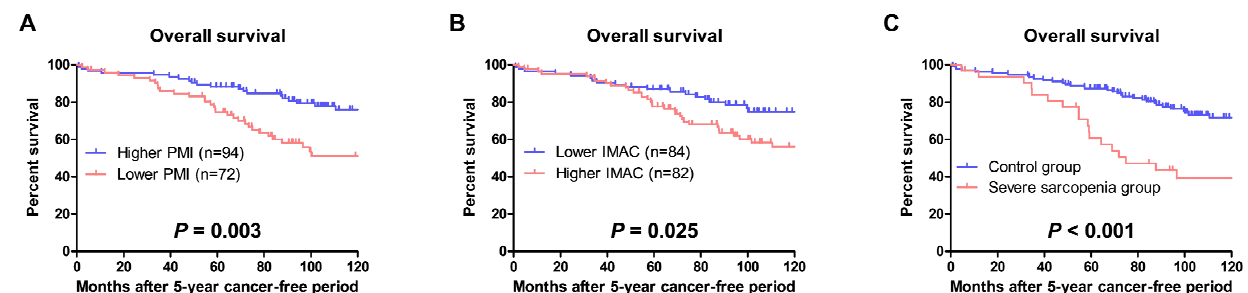
Figure 4. Overall survival. Overall survival after a 5-year cancer-free period was evaluated using the Kaplan–Meier method and compared using the log-rank test between patients with higher and lower psoas muscle index (PMI) values ( A ), lower and higher intramuscular adipose tissue content (IMAC) values ( B ), and patients in the control and severe sarcopenia groups ( C ). By the end of the follow-up period after the 5-year cancer-free period, 37 (28%) and 21 (66%) patients in the control and severe sarcopenia group died from non-cancer-spe- cific cause, respectively. The 5-year and 10-year non-cancer-specific mortality rates in the severe sarcopenia group were significantly higher than those in the control group (Figure 5A,B; 38% vs. 10%, p < 0.001; 56% vs. 21%, p < 0.001; respectively). The non-cancer-specific survival in patients with lower PMI values was significantly shorter than that in patients with higher PMI values (Figure 5C, p = 0.001). The non-cancer-specific survival in patients with higher IMAC values was significantly shorter than that in patients with lower IMAC